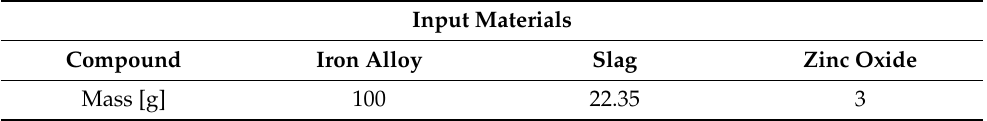
Table 3. Amounts of used input